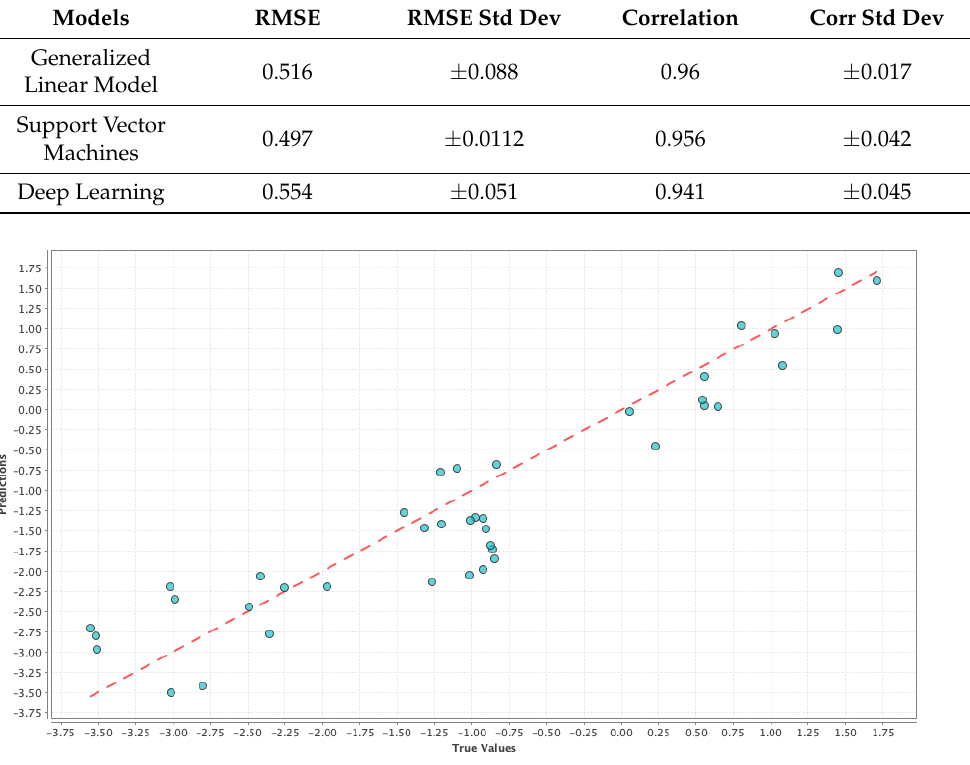
Figure 7. Result on Test Set For Generalized Linear Model using Model 10 from Table 3. The x-axis represents the true or the actual PDSI values and the y-axis represents the predicted PDSI values. Each small blue circle in the figures is represented by the tuple ( PDSI actual , PDSI pred ). The red dashed line is the reference line to test the model